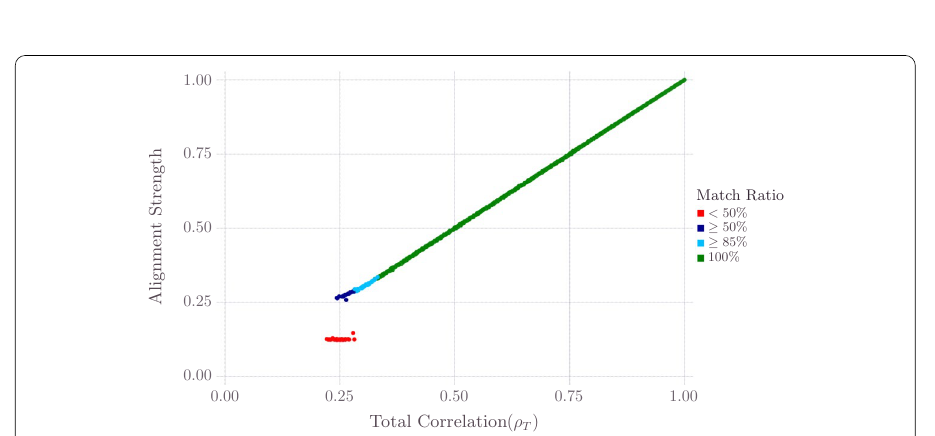
Fig. 5 Experiment B in Sect. “Block settings”; same as Experiment A except that F 2,2 is uniform [0, 1]